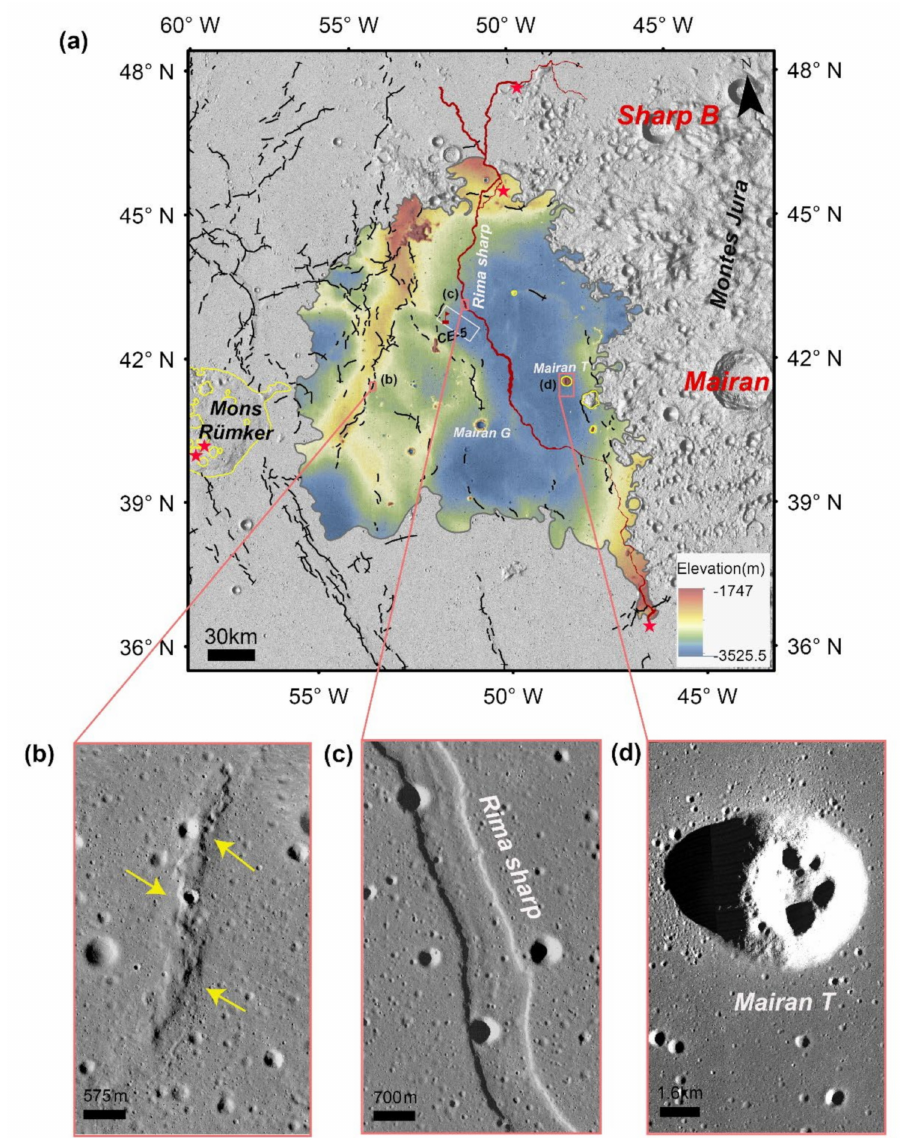
Figure 3. ( a ) Topography of the Em4 unit and surrounding terrains. The elevation is Kaguya TC DTM. The base image is SLDEM2015 hillshade. The yellow lines denote volcanic domes. The red stars denote volcanic vents. The crimson lines denote Rima Sharp. The black lines denote wrinkle ridges. The red flag marks the CE-5 landing site. The white line denotes the boundaries of Em4c. The grey line denotes the geologic boundaries of Em4. ( b ) Wrinkle ridge (53.96 ◦ W, 41.79 ◦ N). ( c ) Rima sharp (51.40 ◦ W, 43.48 ◦ N). ( d ) Mairan T Dome (48.51 ◦ W, 41.79 ◦ N). Xiao et al. [43] found that the material may be quick or migrate slowly in areas with larger slope. They confirmed that topographic slope will affect the density and size- frequency distribution of craters by counting craters on the geologic units with the same age and different inclines. In order to preclude the influence of inclined topography in crater statistics, we avoided areas developed with geologic